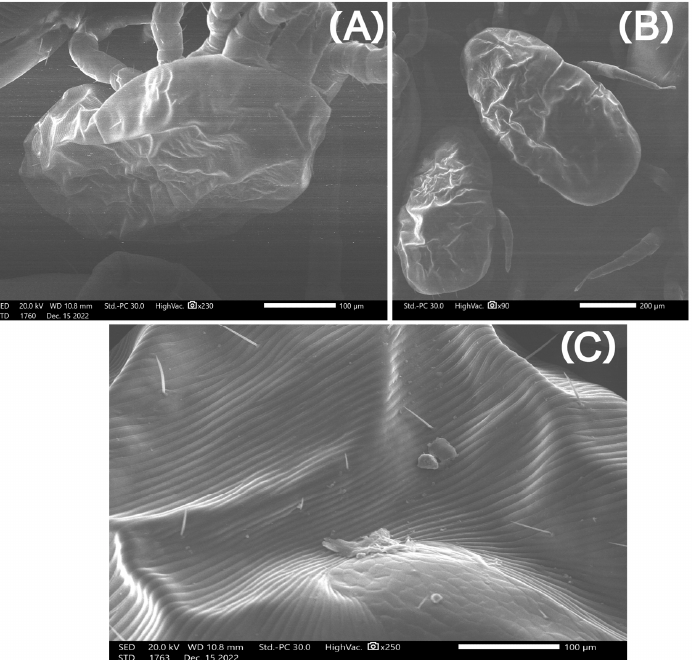
Figure 4. Micrographs of Dermanyssus gallinae after placing them in 99% ethanol for 1 day. ( A – C ) There is a loss of external morphological characteristics, severe dehydration, and large indentations in the exoskeleton.